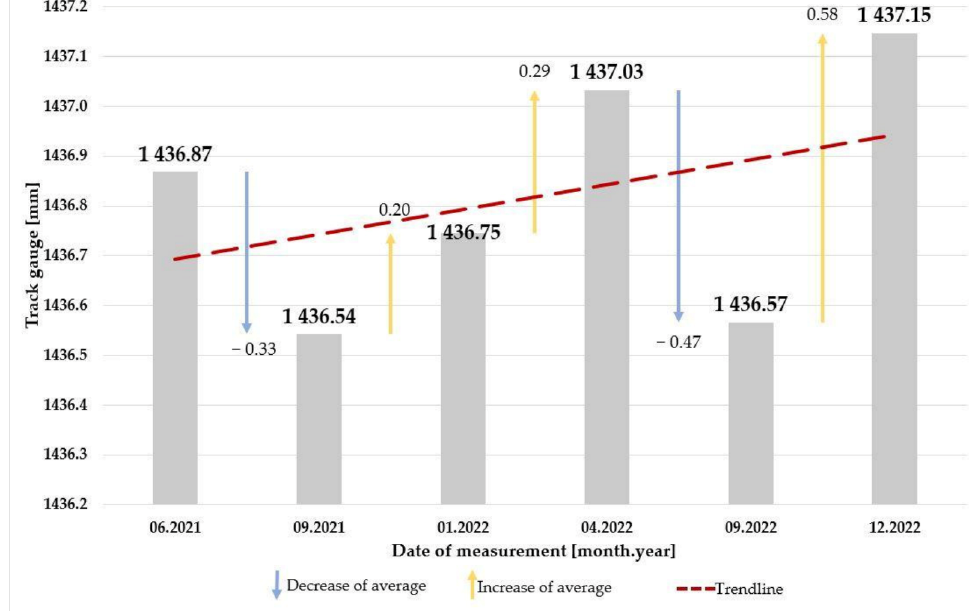
Figure 22. The change of average values of the track gauge in Section #7.